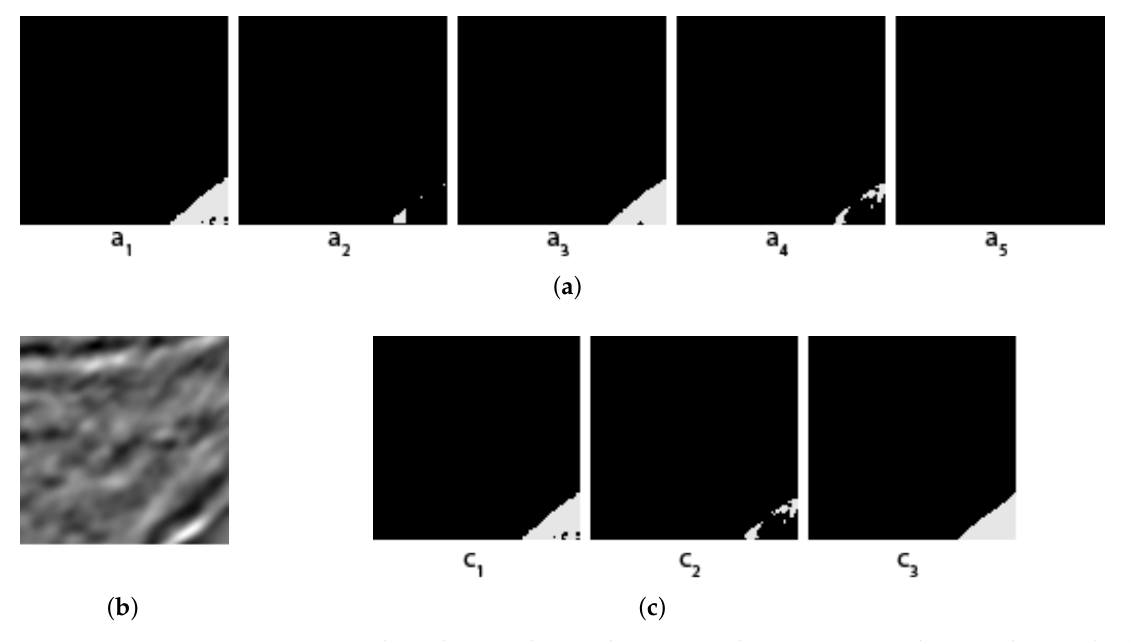
Figure 4. Topological vs. Arithmetical voting in salt segmentation -The second Example. ( a ) Masks created by 5 individual segmentors (from 5 folds); ( b ) Original image; ( c ) C 1 : Topological voting, C 2 : Arithmetical voting, C 3 : True mask.